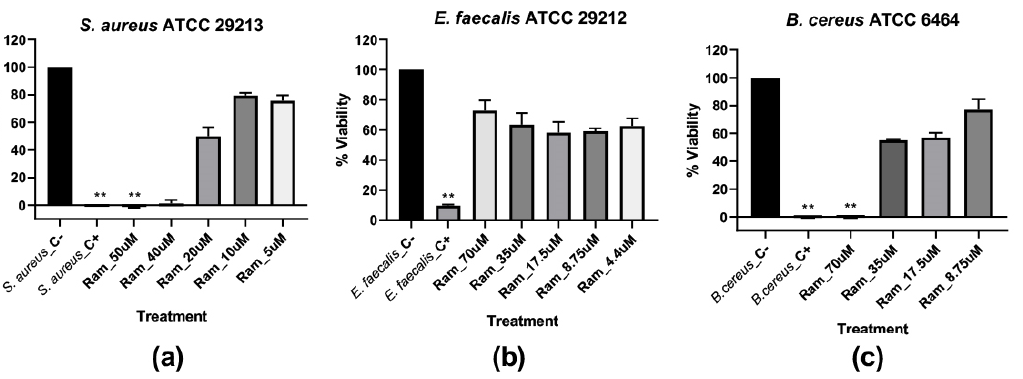
Figure 3. Endpoint assay to determine viability percentage of Gram-positive bacteria after 19 h of Ramosin treatment by broth microdilution assay. The bacteria S. aureus , E. faecalis, and B. cereus without treatment were used as a negative control, and NaClO at 0.012% was used as a positive control for death. ( a ) S. aureus ATCC 29213. ( b ) E. faecalis ATCC 29212. ( c ) B. cereus ATCC 6464. Absorbance reading at 600 nm. Three independent experiments were carried out for each bacterial strain. Data are presented as mean ± SD. **: p < 0.01.